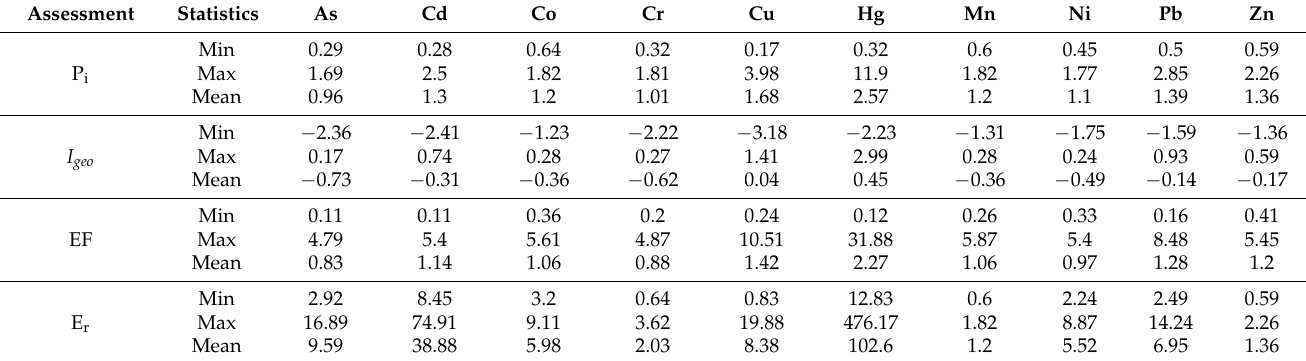
Table 9. Statistics of heavy metals in farmland soils in the study area.